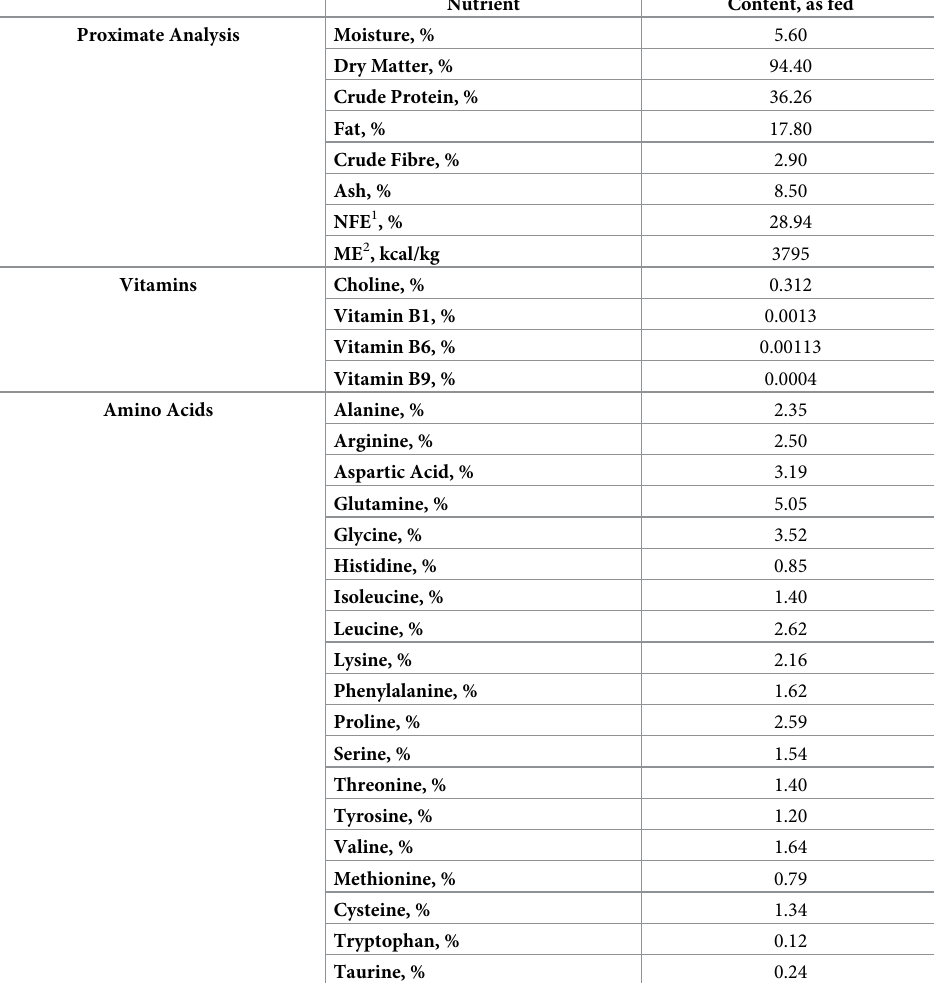
Table 1. Dietary analysis (as fed) of the base diet, a commercial extruded kitten food, fed to all kittens in a choline supplementation study.